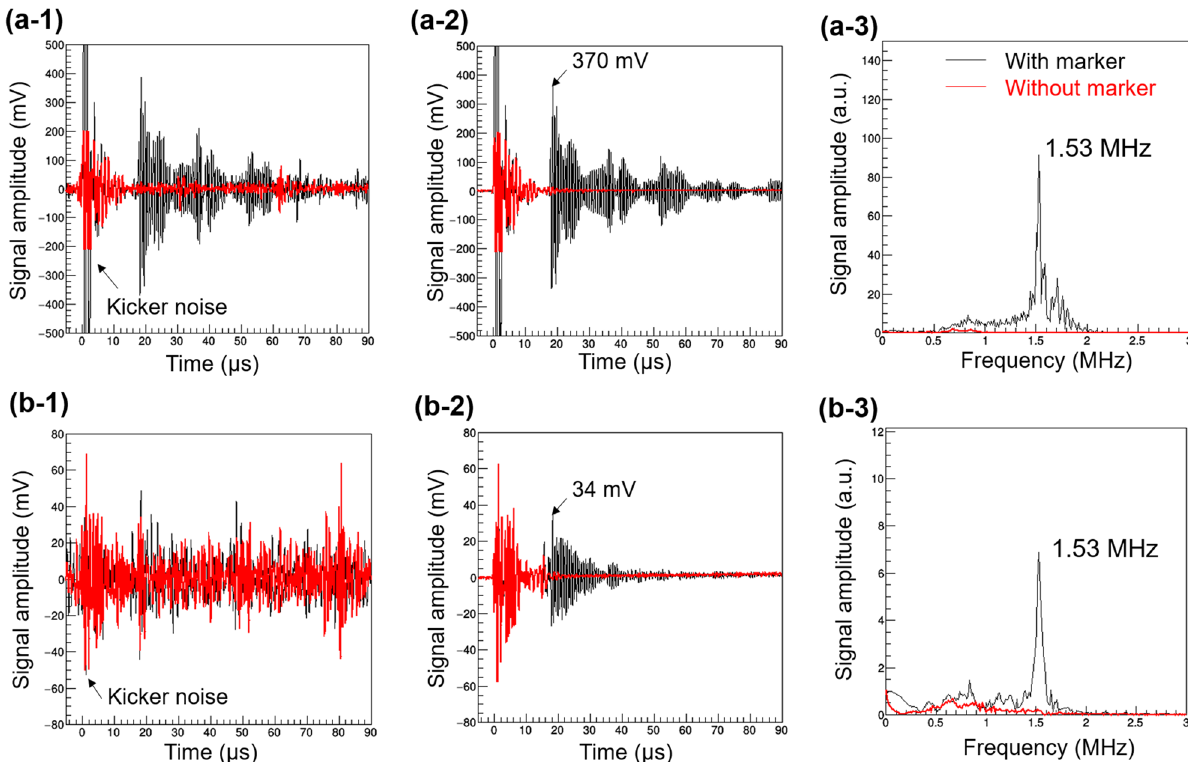
Figure 3. Measuring the waveforms and frequency spectra of a SPIRE. SPIRE waveforms obtained by ( a ) the LFH and ( b ) the V397-SU. Data from a single measurement (left-hand column) and the results of averaging over 1000 measurements (central column) are shown. Time zero represents the time of irradiation by the beam. The black and red lines denote the results obtained with and without the spherical gold marker,